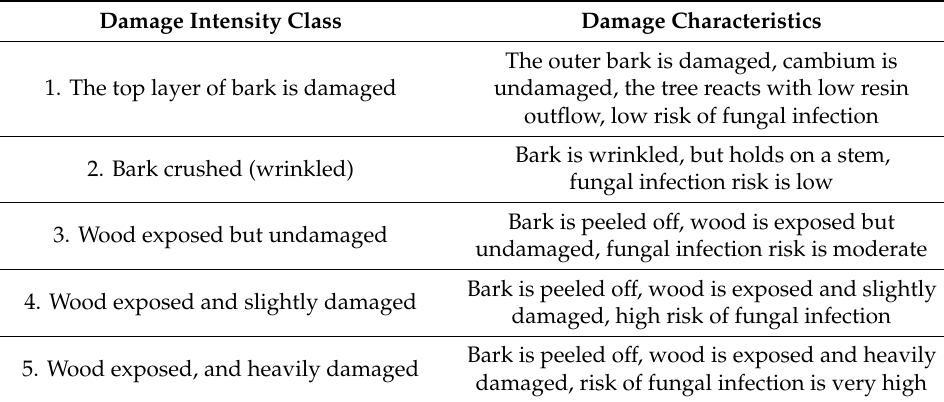
Table 5. Classification of damage intensity